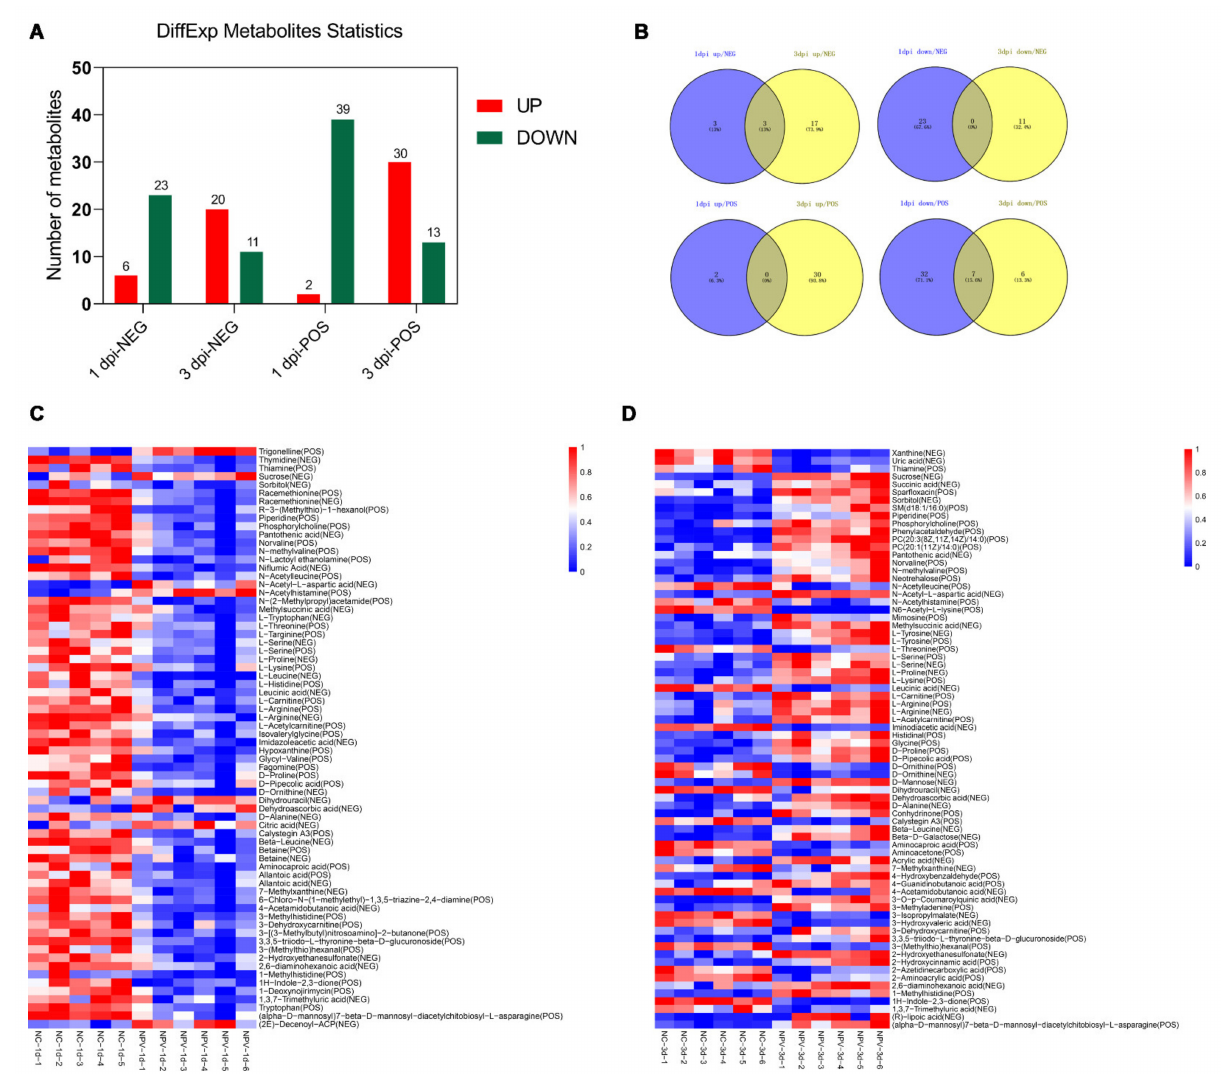
Figure 4. Analysis of differentially expressed (DE) metabolites in hemolymph of BmNPV-infected and uninfected silkworms. ( A ) Numbers of metabolites that were up-regulated (red) and down-regulated (green) in BmNPV-infected silkworm larvae. ( B ) Venn diagrams provide a global overview of the common and DE of metabolites between the 1 d and 3 d groups. ( C , D ) Heatmaps of DE metabolites in hemolymph at 1 d ( C ) and 3 d ( D ) after BmNPV infection. Each column represents one sample, and each row represents one DE metabolite. Red color represents the relative level of the up-regulated metabolites, and blue color represents